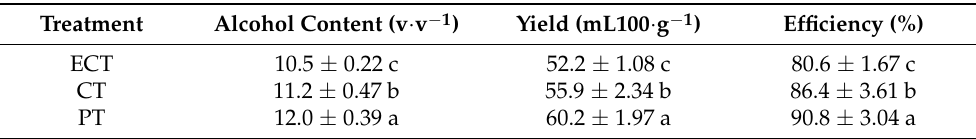
Table 3. Final alcohol content and fermentation yield and efficiency of energy cane juice (ECT), corn (CT), and corn plus energy cane